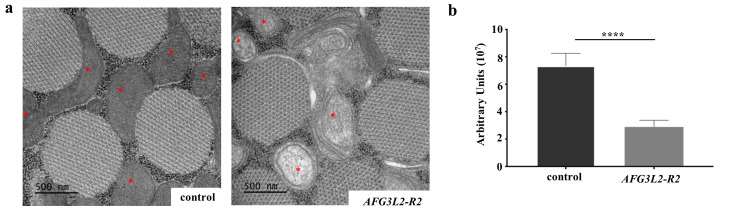
Afg3l2 deficiency results in mitochondrial morphological defects.a. Transmission electron microscopy images of indirect flight muscles from control animals (UAS-LUCIFERASE RNAi/24B-Gal4) and from flies expressing the strong AFG3L2-R2 RNAi (UAS-AFG3L2-R2 RNAi/24B-Gal4) using the mesoderm specific 24B-Gal4 driver. Images are of indirect flight muscles dissected from pupae. The red asterisks denote the mitochondria. b. Quantification of mitochondrial cristae density in control (UAS-LUCIFERASE RNAi/24B-Gal4) and AFG3L2-deficient (UAS-AFG3L2-R2 RNAi/24B-Gal4) animals (****p < 0.0005 by Student’s t-test).